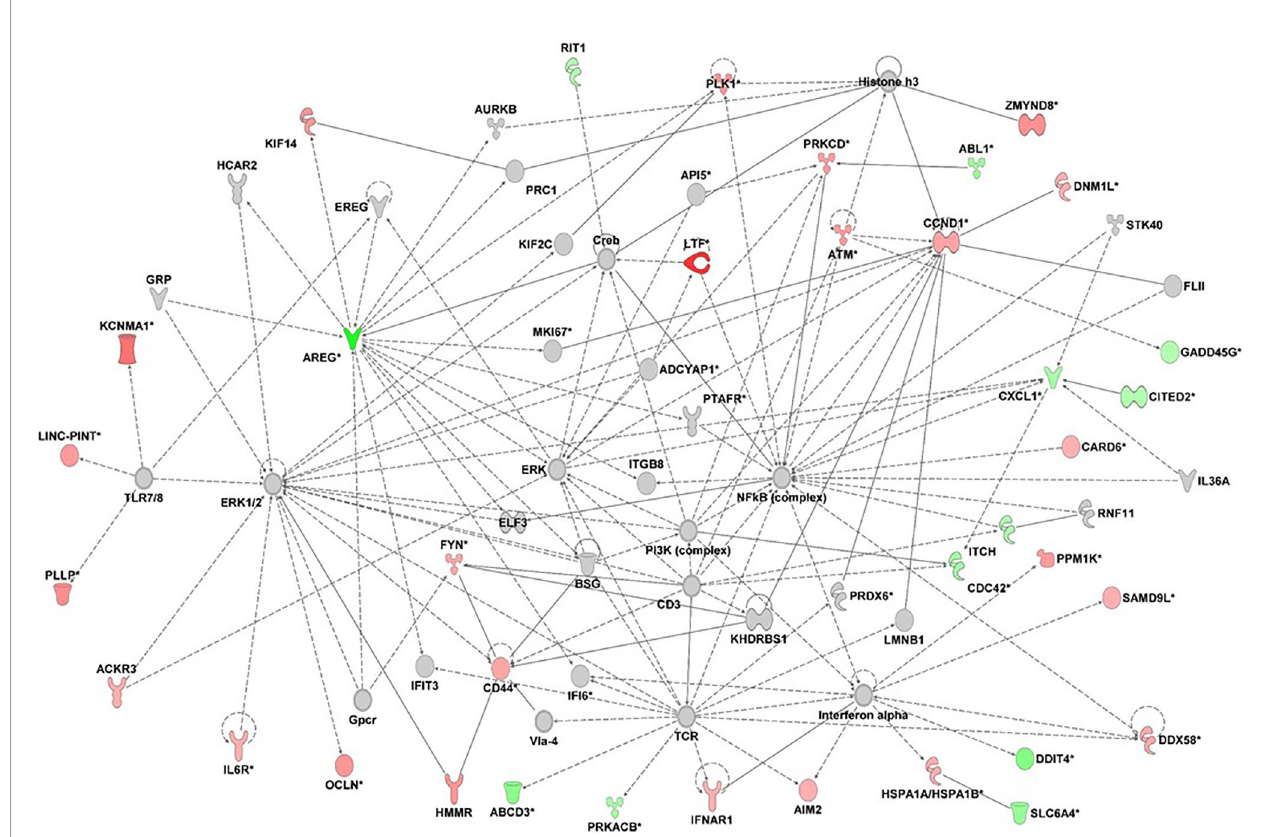
FIGURE 4 | Gene network analysis derived from differentially expressed genes (fold change +/- 1.5) of 20 patients with type 1 diabetes in relation to 20 health controls (p<0.05). Red= up-regulated genes; green= downregulated genes; ::= direct interaction; — = indirect interaction. the graph was done with IPA-Ingenuity Pathways Analysis,